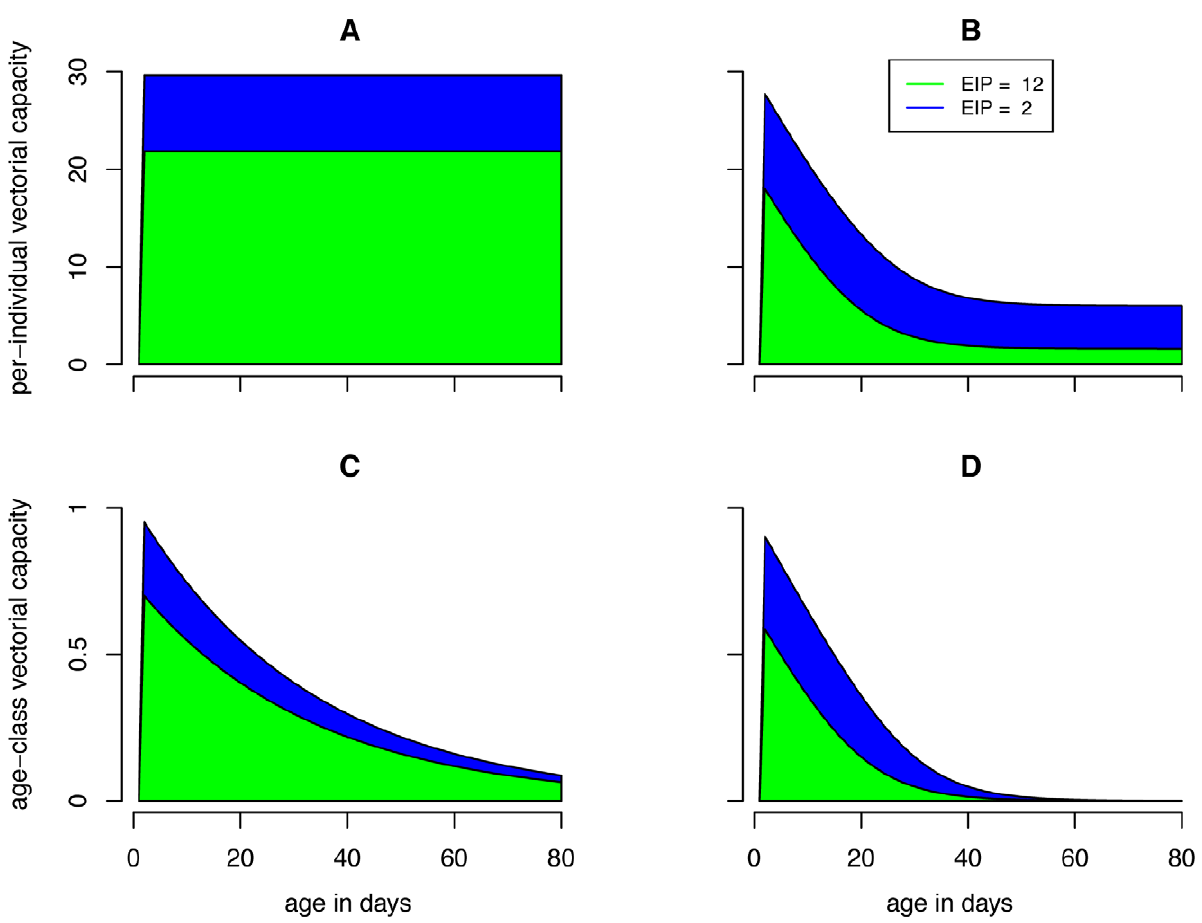
Figure 2. Vectorial capacity contribution by age and age class. Panels (A) and (B) show the individual-level contribution to scaled vectorial capacity ( C* ) by age; and panels (C) and (D) show the contribution of each age class to C* . The left panels assume constant mortality rates while the right panels assume age dependent mortality rates. Pathogens with shorter extrinsic incubation periods (EIP) allow mosquitoes to transmit sooner after they become infected. For that reason, mosquitoes of all ages contribute more to C* . The blue region shows the extra C* contributed for an EIP of 2 in addition to that for an EIP of 12 given all else held constant. The sensitivity of C* to the EIP is more dramatic in the age dependent model (D) compared to the constant model